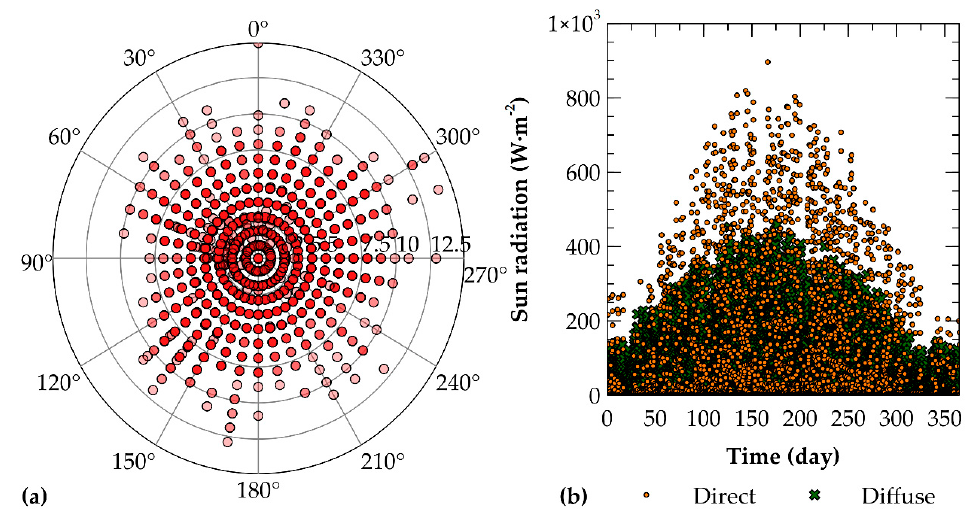
Figure 9. Reference weather data of Olomouc, Czech Republic: ( a ) summary of wind velocities and directions; ( b ) summary of sun radiation.